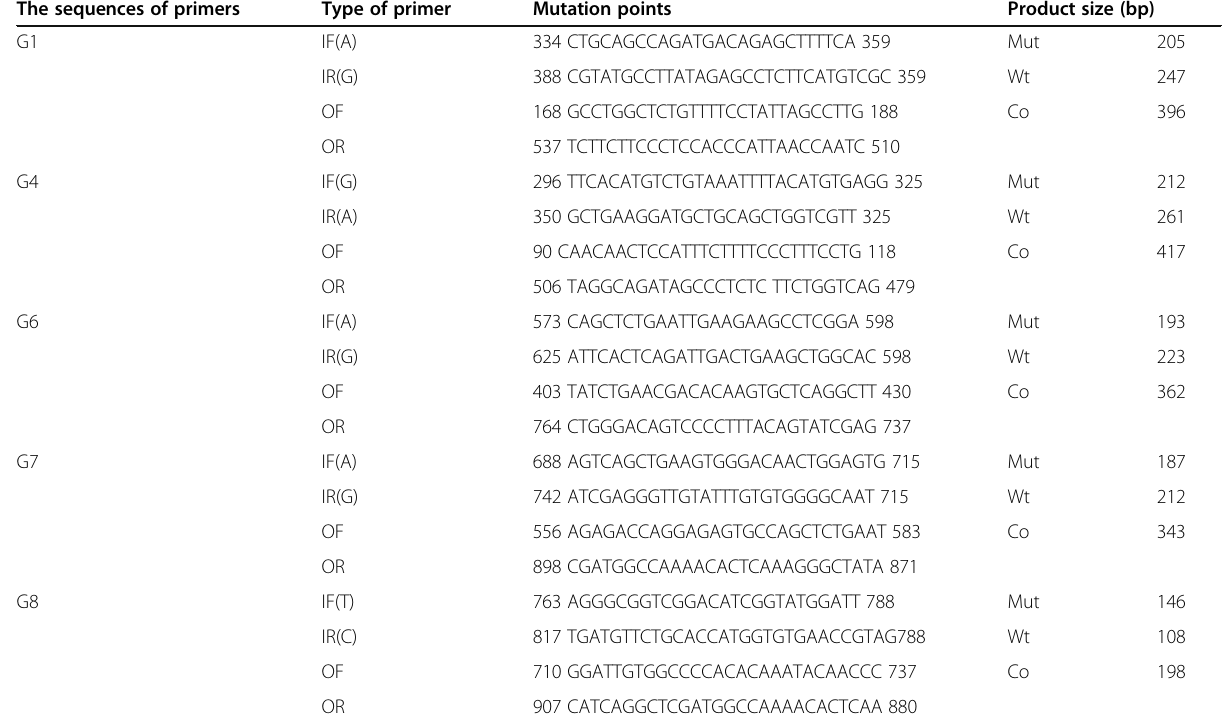
Table 1 The sequences of primers T-ARMS-PCR based amplification of GDF9 gene mutation points The sequences of